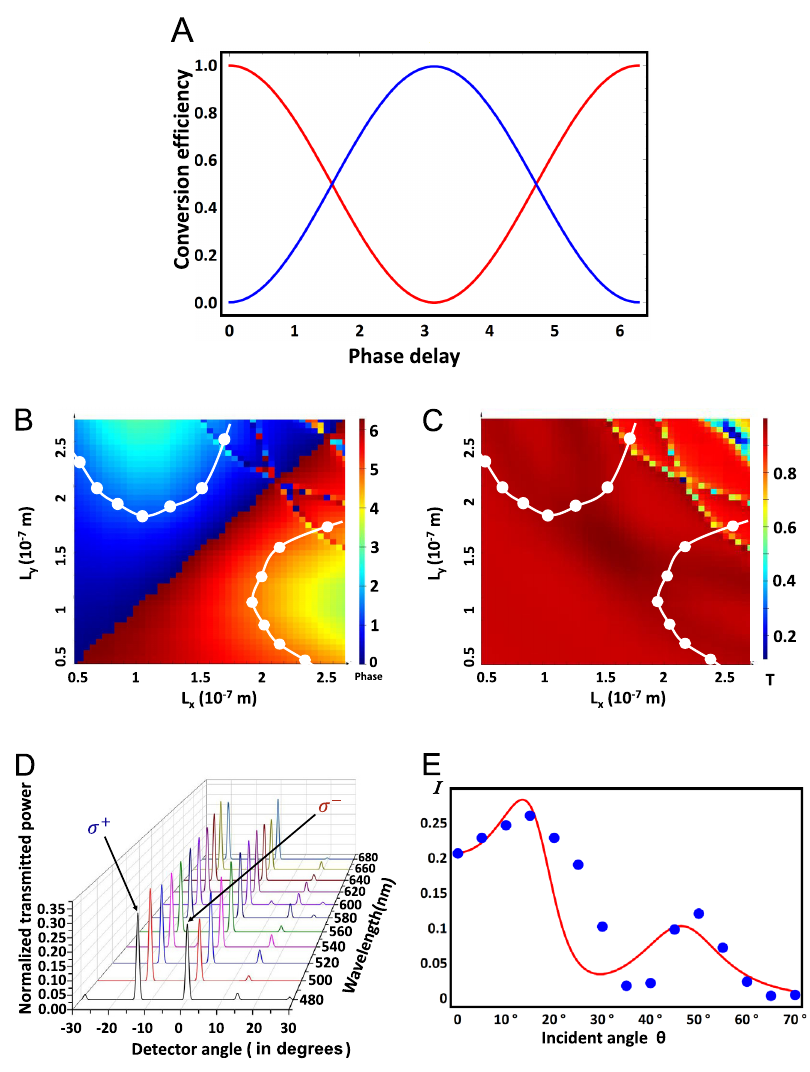
shown in Figure 2A, the ratio of the copolarized and cross- polarized transmission amplitude reach 50/50 when the phase difference of the diagonal elements of susceptibility tensor is π /2 or 3 π /2. In order to identify GaN nanopillars with π /2 or 3 π /2 phase delay between x and y polarizations, full wave numerical simulations is performed to extract the phase retardation between E x and E y components and also the transmission ef fi ciency as function of length and width of the nanopillars in Figure 2B and C. The white lines indicate the regions for which the phase delay between x and y polarizations is equal to π /2 and 3 π /2, needed to adjust amplitudes for the interferometric characterization of the PB phase. According to these theoretical prediction, dimensions of GaN nanopillars used were length l l x = 260 nm, y = 85 nm and height 800 nm. These di- mensions generate phase retardation 3 π /4 between E x and